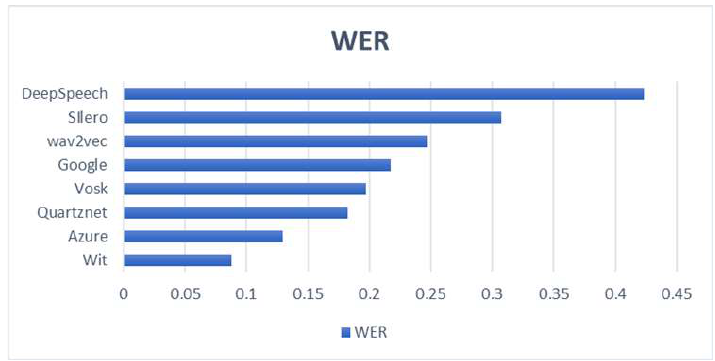
Figure 8 . Comparison of accuracy between different STT modules. Figure 8. Comparison of accuracy between different STT modules.